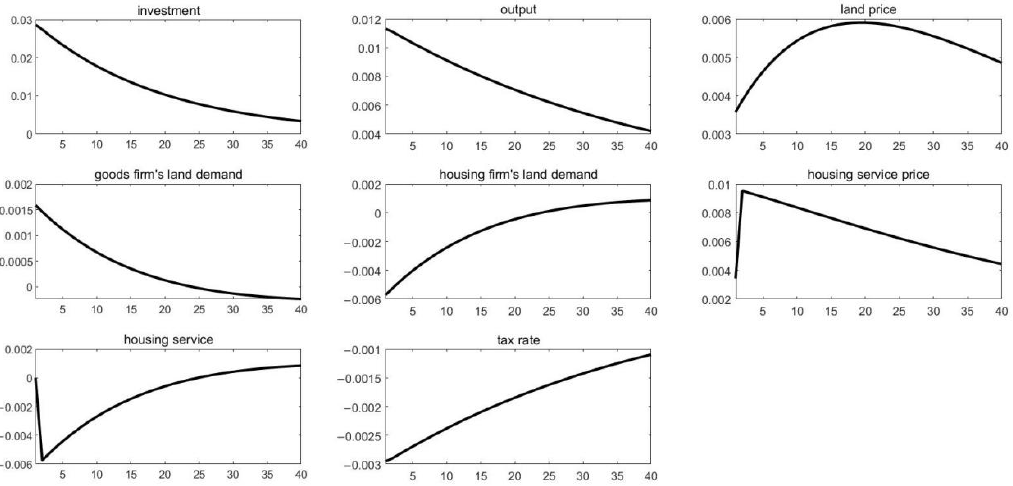
γ= 1). Figure 7. Impulse responses to a positive (one standard deviation) TFP shock (fix land, γ =